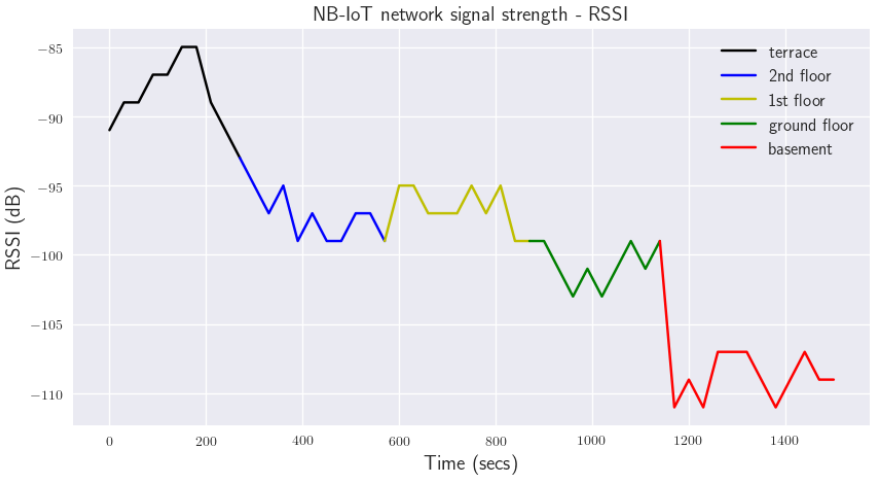
Figure 8. NB-IoT signal